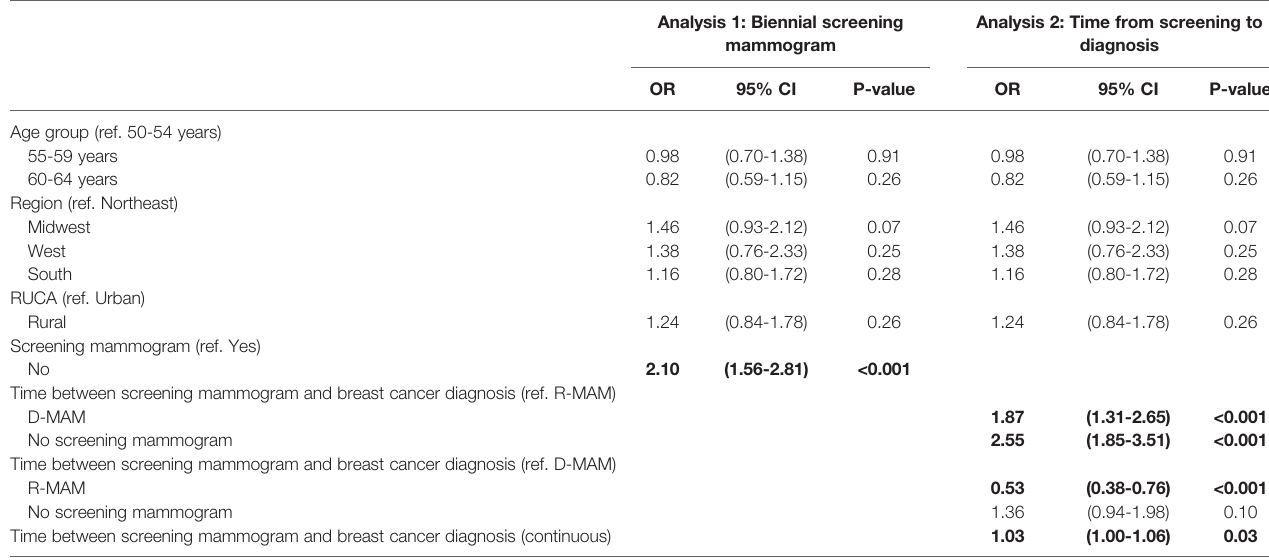
TABLE 2 | Univariate ordinal logistic regression analysis on the odds of having a later stage breast cancer diagnosis for women aged 50-64 using age group, region, RUCA category, and (analysis 1) presence of a screening mammogram or (analysis 2) grouped and continuous time from screening to diagnosis as predictors.